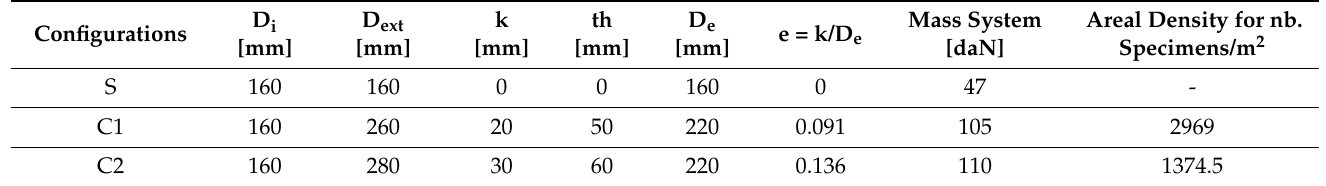
Table 2. Synthesis of the studied roughness parameters for all configurations.